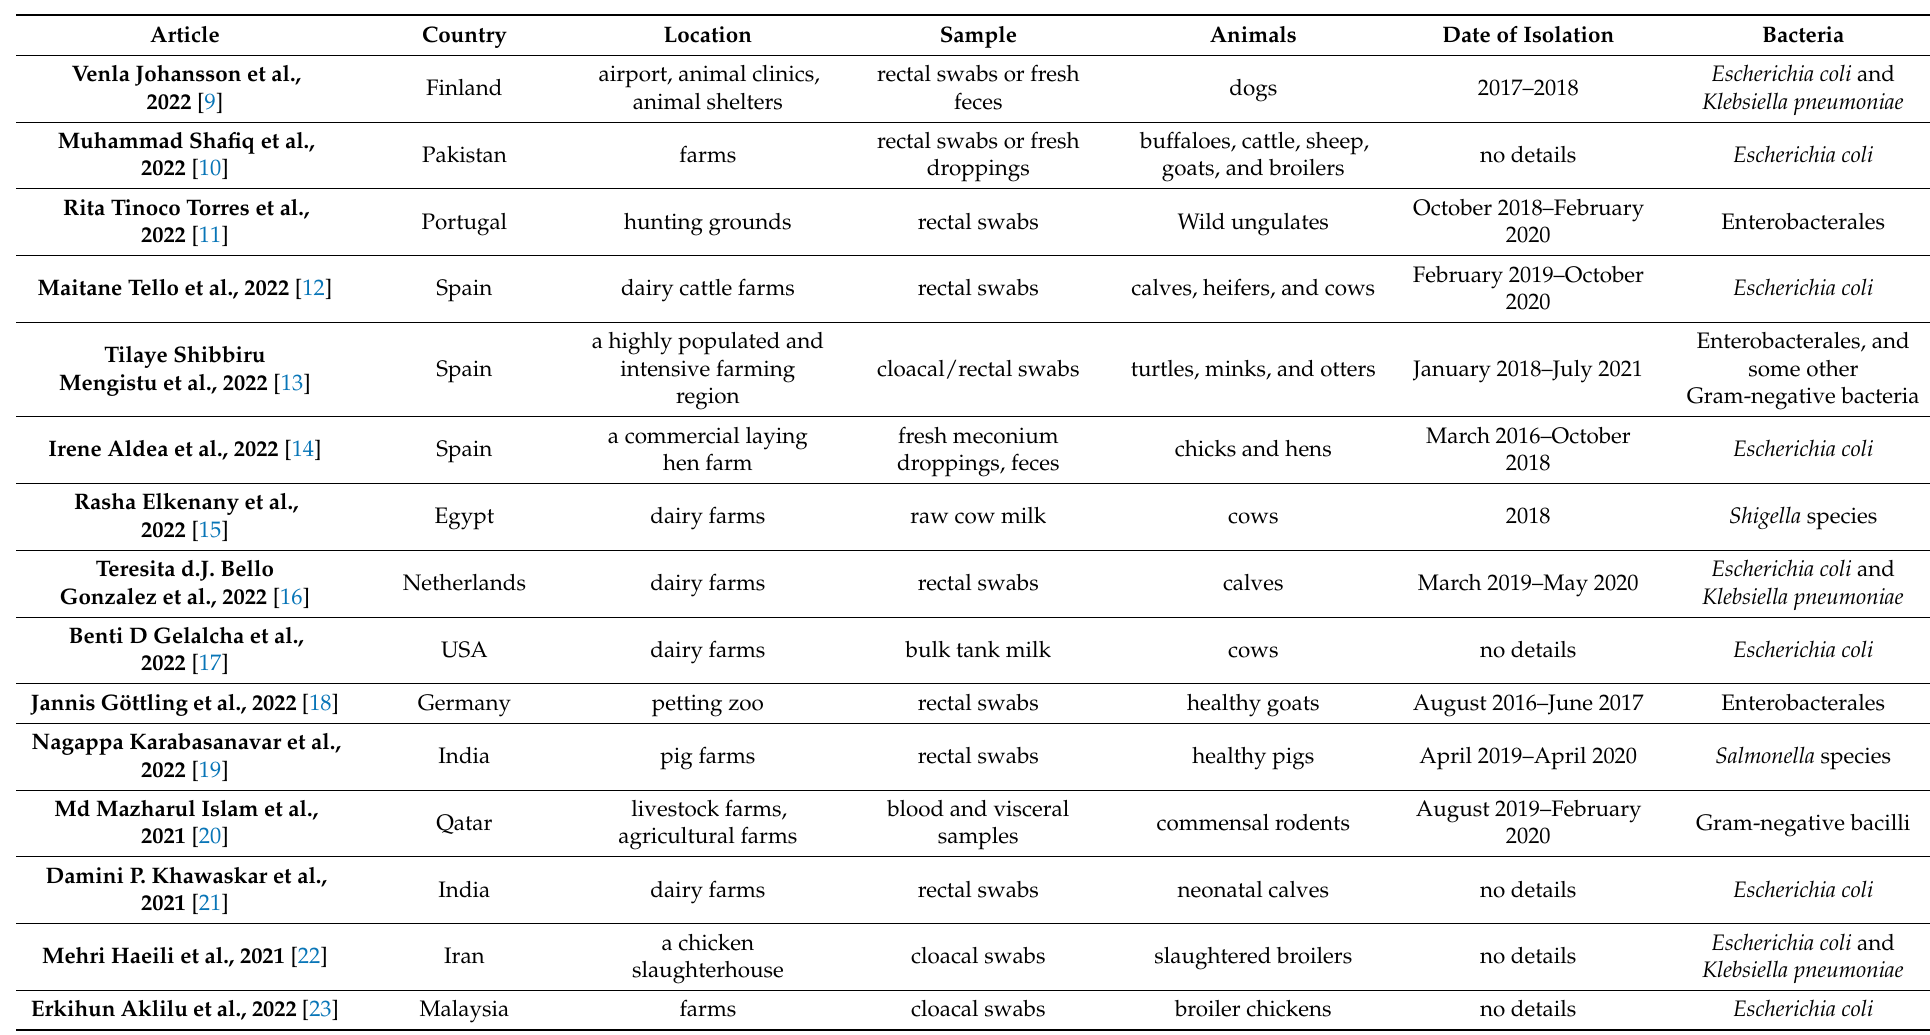
Table 1. Studies of ESBL-producing bacteria in